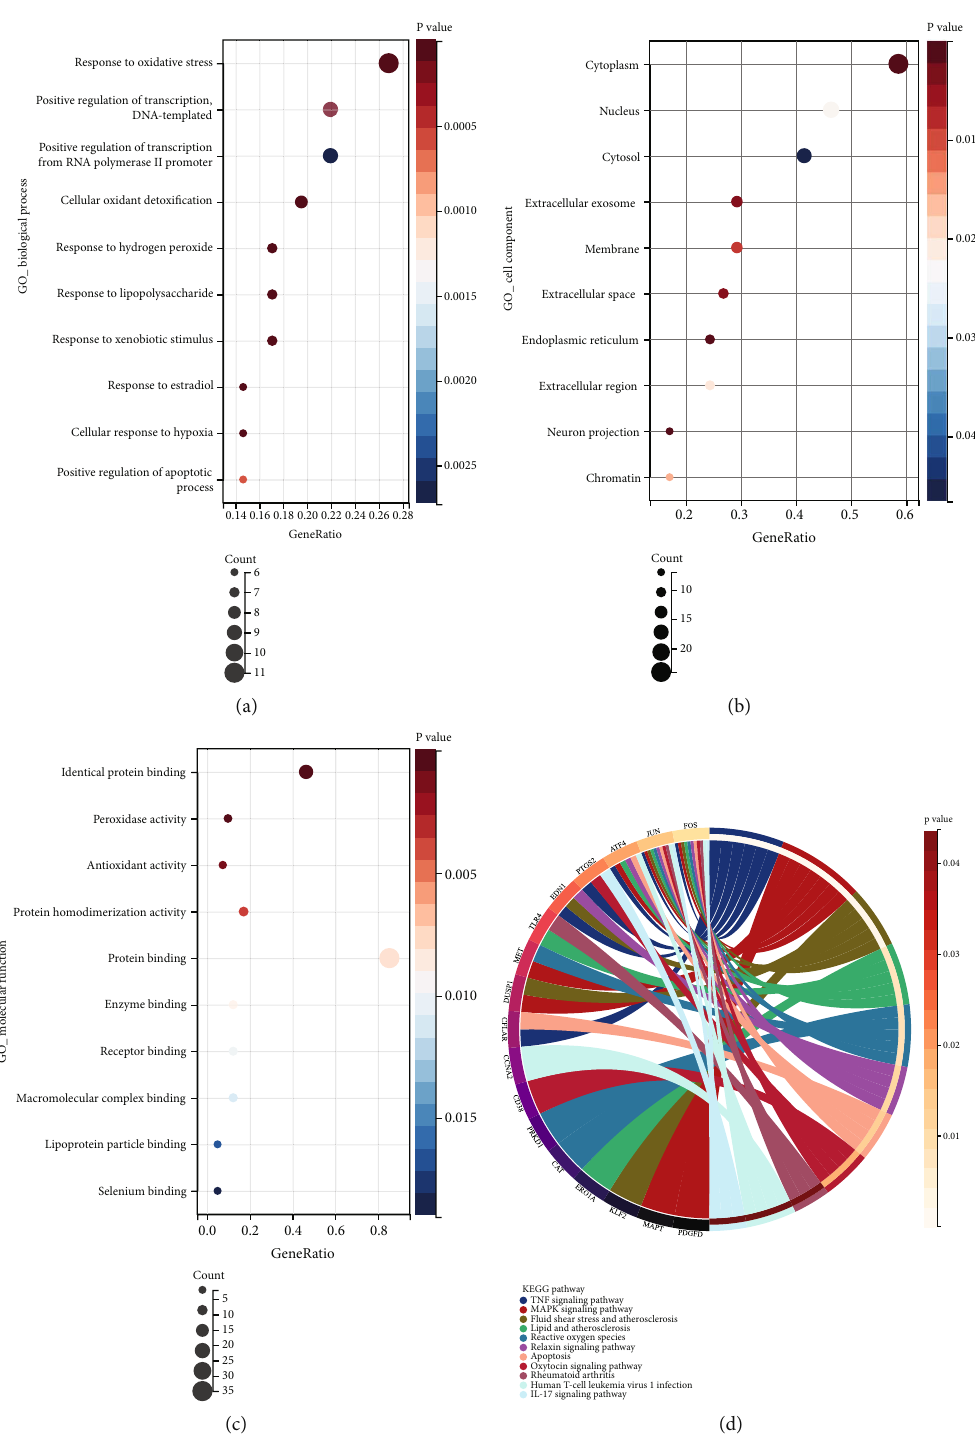
Figure 3: Functional enrichment analysis of OSRDEGs. (a) GO_ biological process; (b) GO _ cell component; (c) GO_ molecular function; (d) KEGG